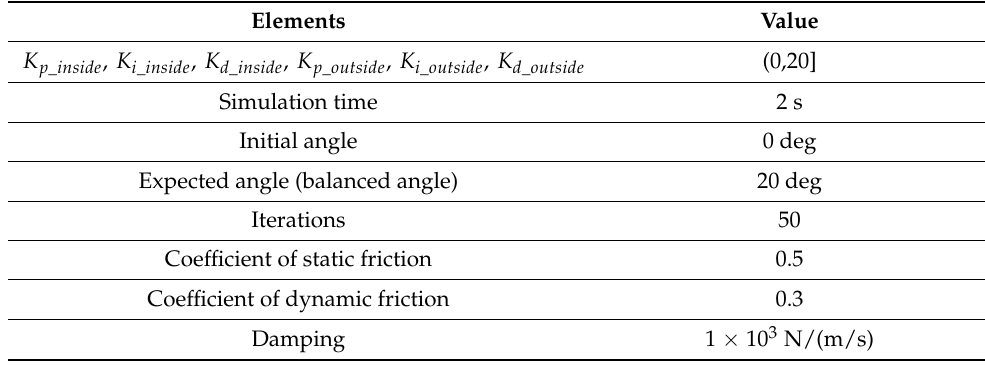
Table 2. Parameters related to metaheuristic algorithm.